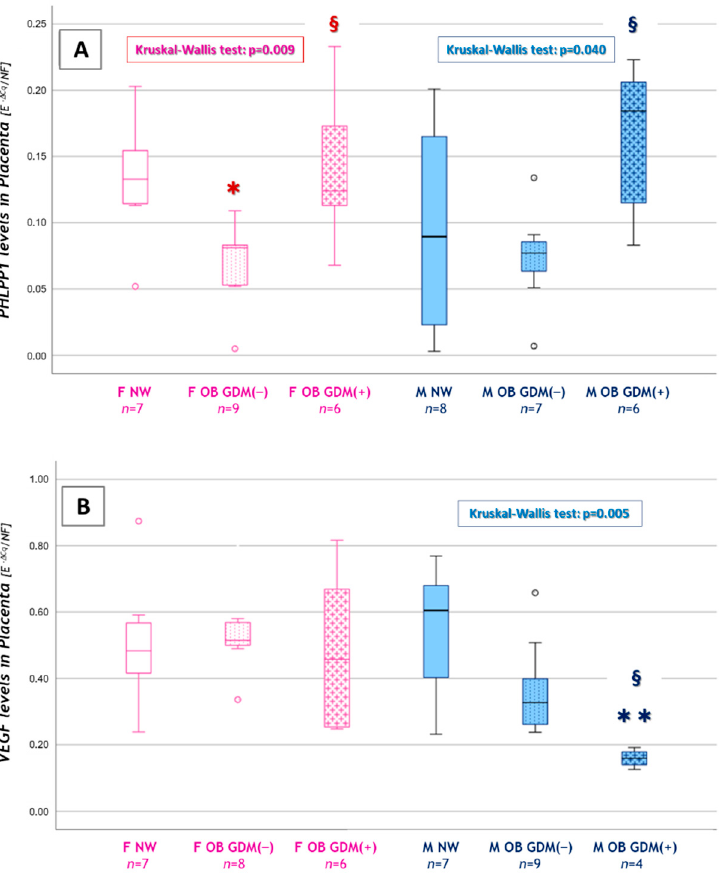
Figure 5. Sexually dimorphic expression of CMA or autophagy-related genes. ( A ) PHLPP1 and ( B ) VEGF levels among female or male placentas in NW, OB GDM( − ) and OB GDM(+). Data were analyzed with Kruskal–Wallis test ( PHLPP1 : p = 0.009 for FEMALE placentas, p = 0.040 for MALE placentas. VEGF : p = 0.005 for MALE placentas). Data are shown as box plots, indicating the median and the 25th and 75th percentiles; ◦ values that extend more than 1.5 box-lengths from the edge of the box. FEMALE Placentas:* p < 0.05 vs. NW or § p < 0.05 vs. OB GDM( − ). MALE Placentas:** p < 0.01 vs. NW or§ p < 0.05 vs. OB GDM( − ); post-hoc by Mann–Whitney U test with Bonferroni